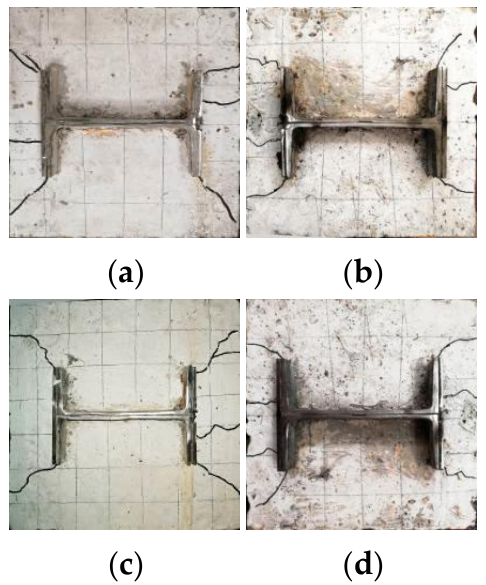
Figure 6. Bonding cracks. ( a ) SRRC02. ( b ) S-SFRAC04. ( c ) S-SFRAC11. ( d ) S-SFRAC16.